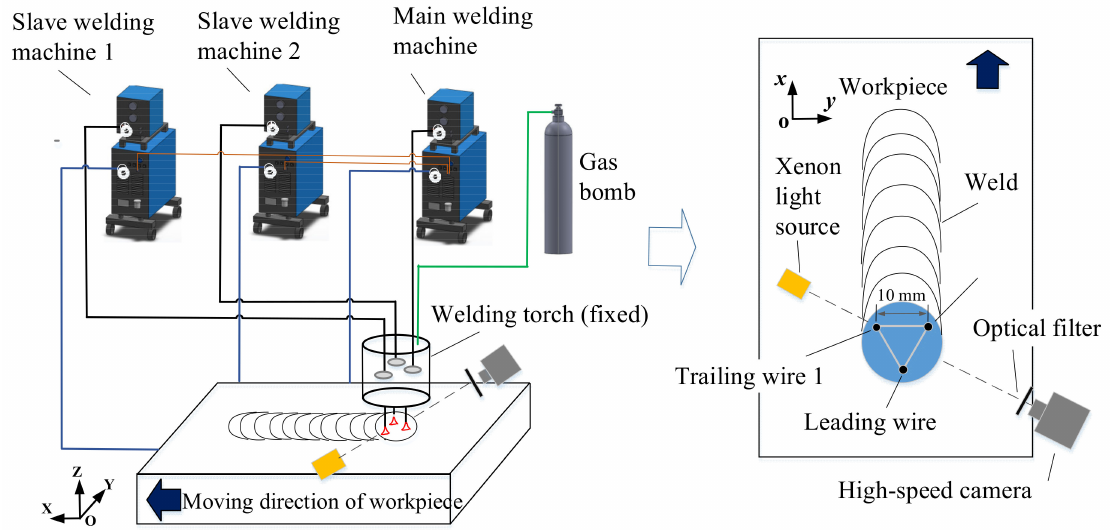
Figure 1. Schematic diagram of an integrated circular triple-wire pulse GMAW